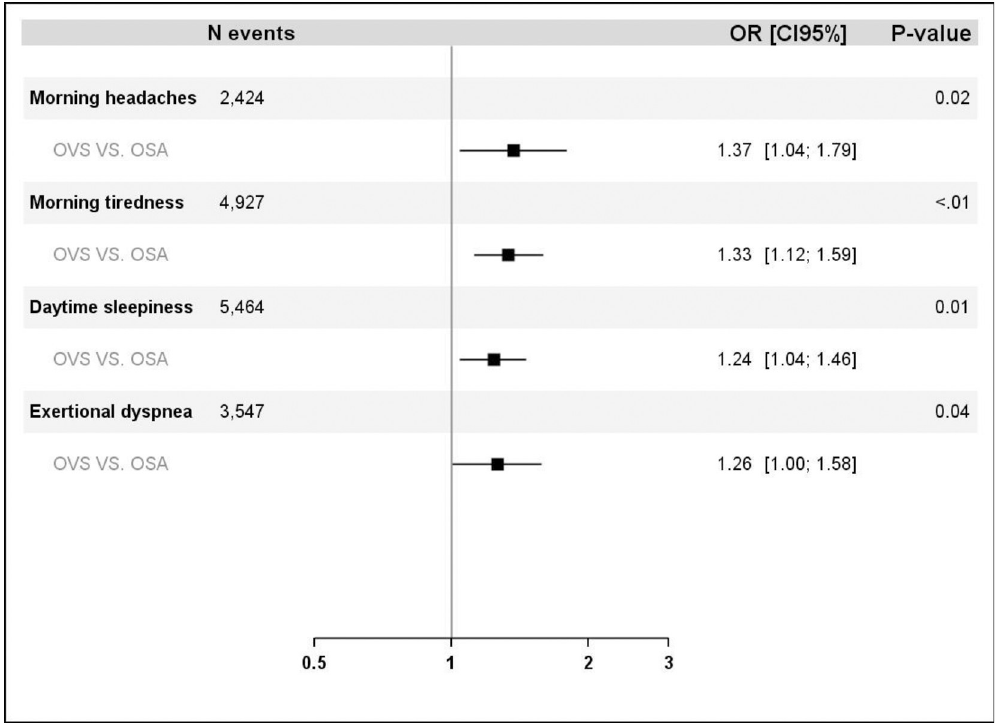
Fig 3. Association between OVS and morning headaches, morning tiredness, daytime sleepiness and exertional dyspnea after controlling for age, gender, BMI, adherence to treatment and residual AHI.